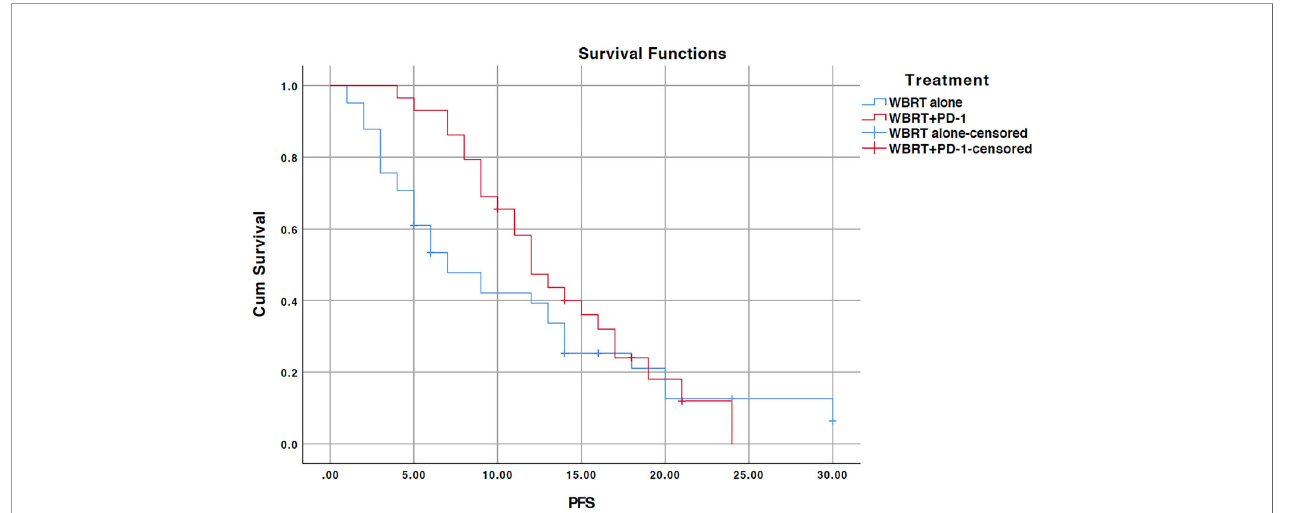
FIGURE 2 | Kaplan-Meier overall survival (OS) curve for treatments in EGFR wildtype NSCLC subgroup; WBRT alone (No PD-1), and WBRT plus PD-1 inhibition therapy (WBRT+PD-1). Cum, cumulative.